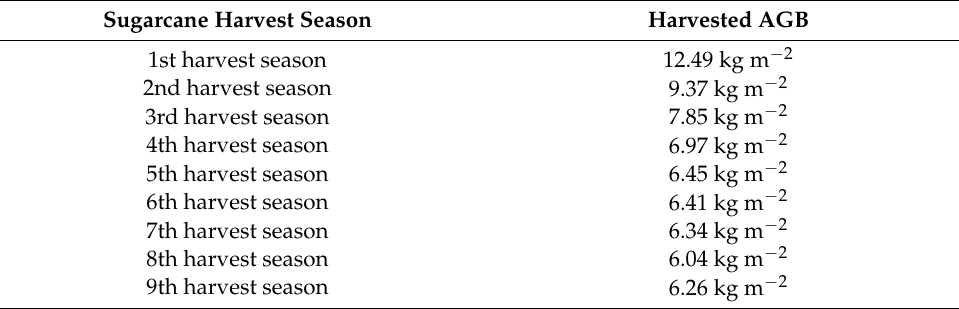
Table 4. History of harvested AGB per harvest